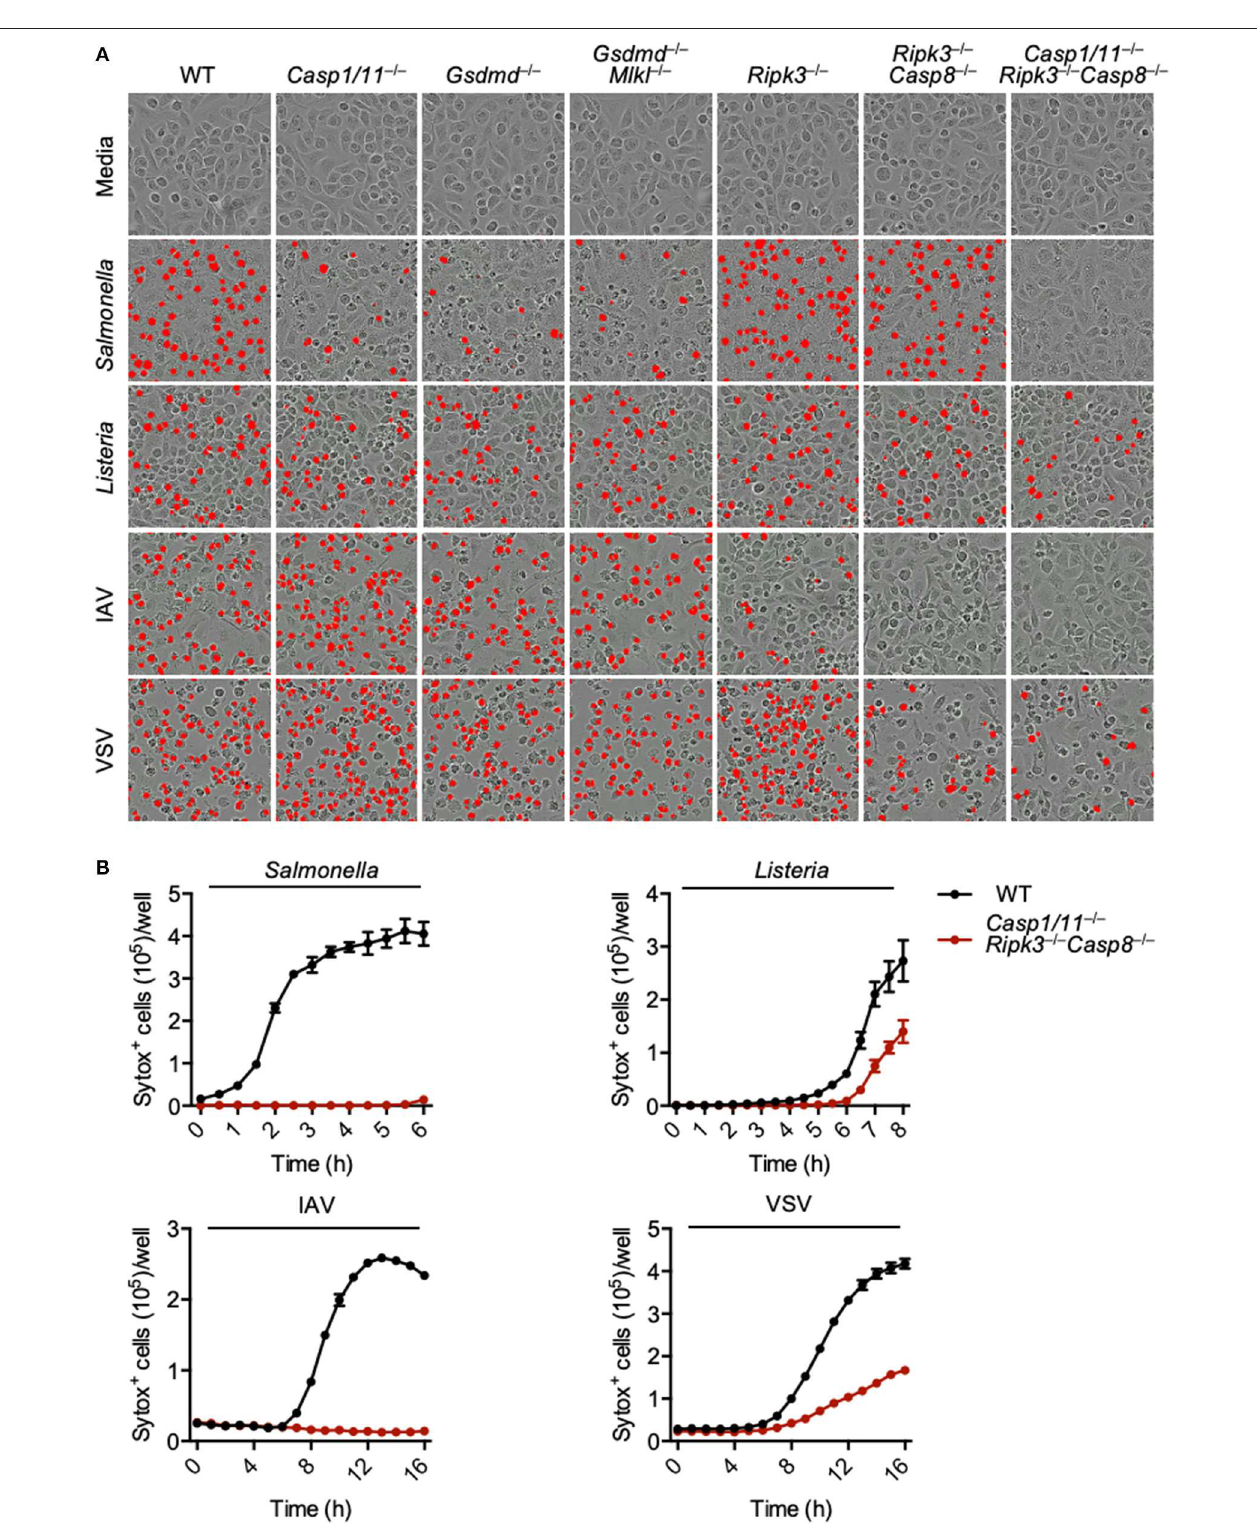
FIGURE 1 | Loss of PANoptotic molecules prevents infection-induced cell death. Cell death analysis of BMDMs lacking different components of pyroptosis, apoptosis, or necroptosis. (A) Representative cell death images with the red mask indicating dead cells and (B) quantification of cell death over time in BMDMs after S. Typhimurium, L. monocytogenes , IAV, and VSV infection.